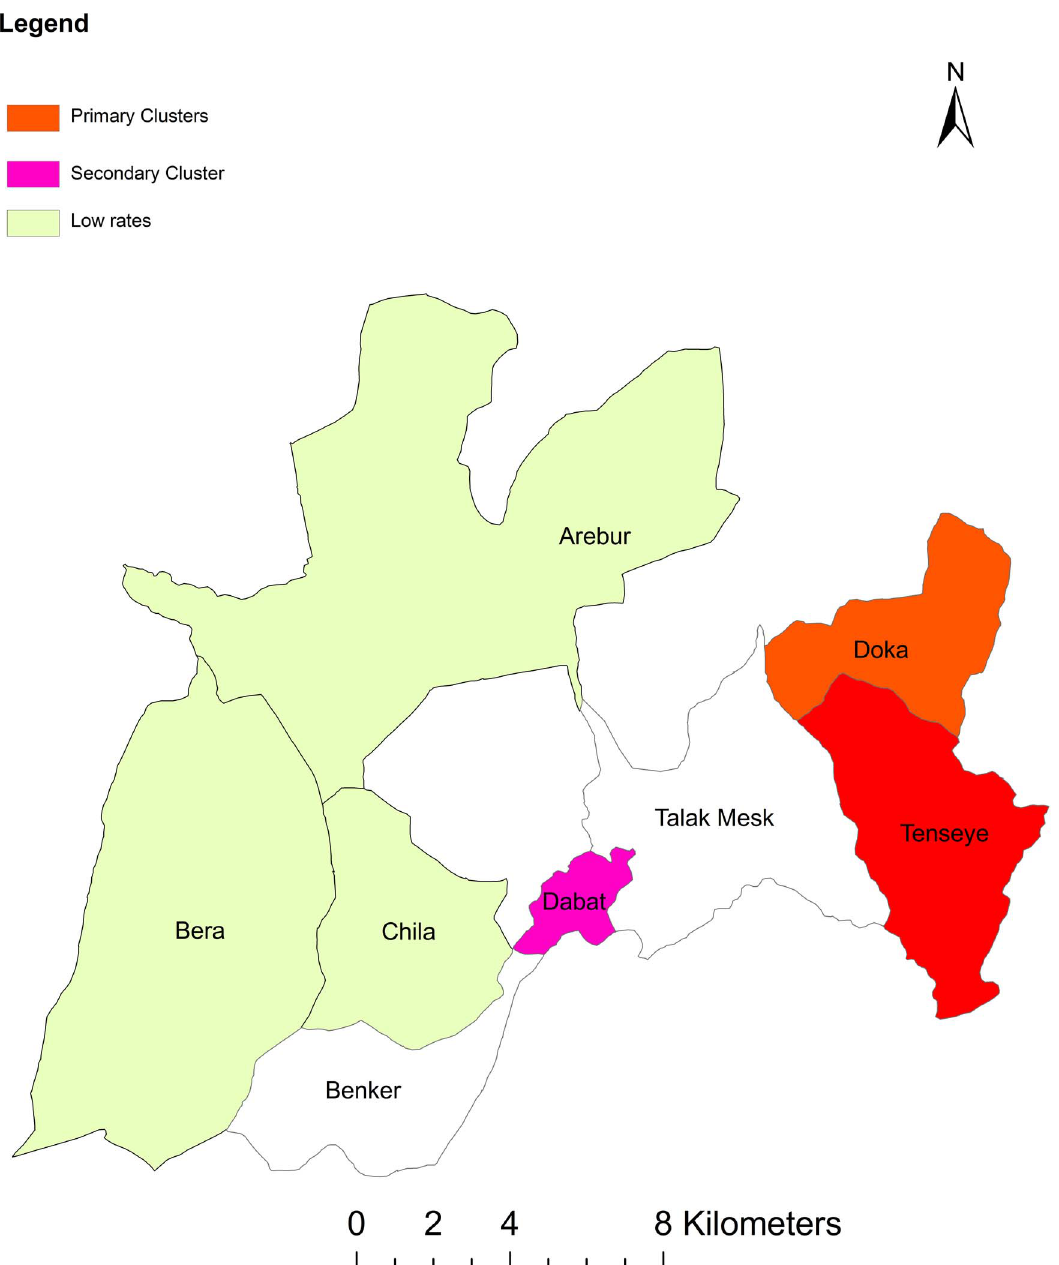
Figure 3. Distributions of high rate and low rate smear-positive TB clusters, in Dabat Ethiopia, 2012.